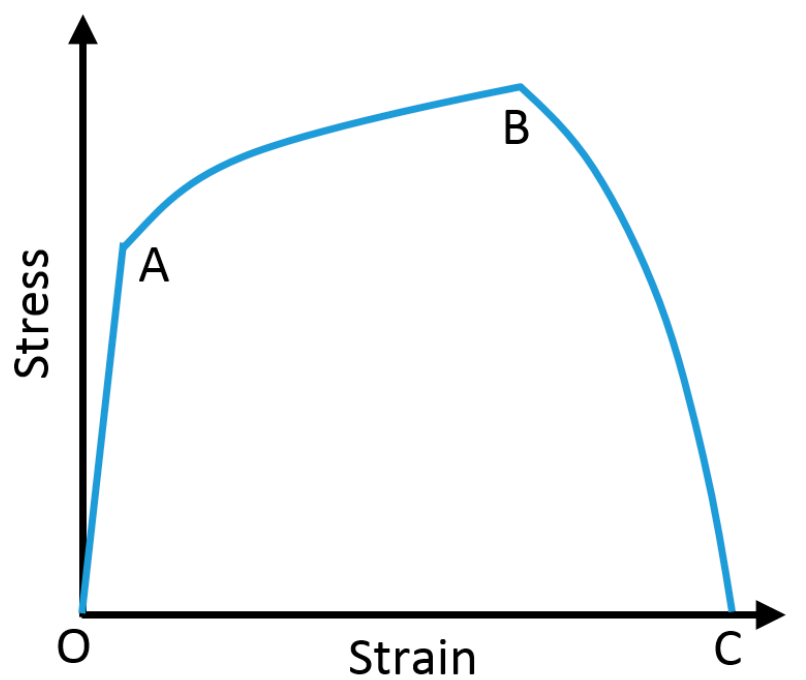
Figure 4. Schematic of damage initiation and evolution in HDPE.